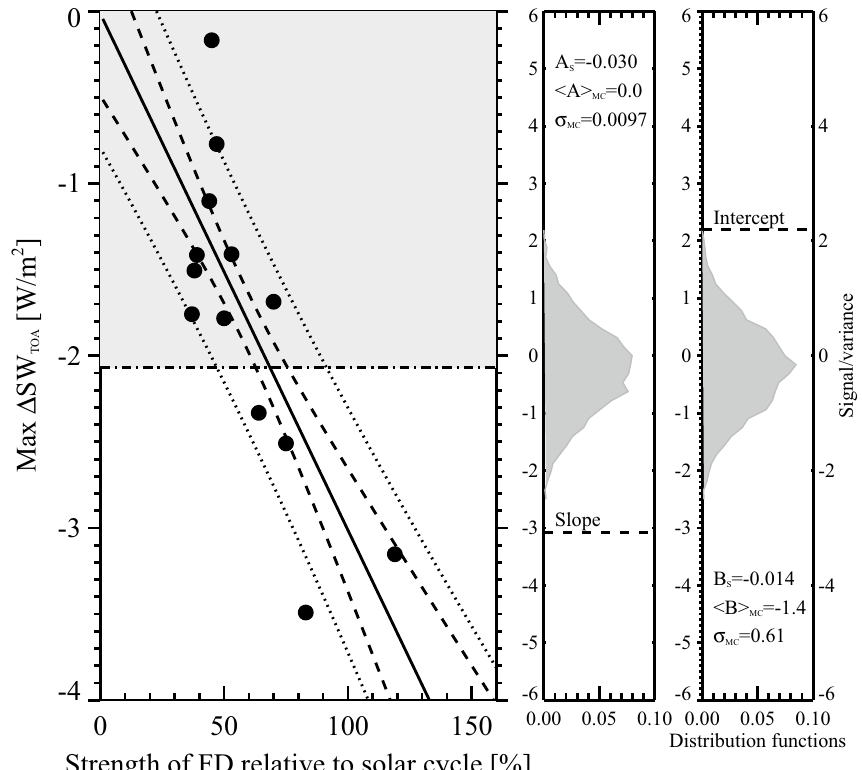
Figure 2. The response of CERES short-wave radiation as a function of FD strength. The left panel shows the most substantial deviation between day 0 and day 10 in short wave radiation globaly averaged for each Forbush decrease as a function of the FD strength (dots). The black line is a linear fit to the 13 data points and the dashed lines and dotted lines represent two and four standard deviations of the fit, respectively. The dash-dotted line is 4 the mean of the most substantial deviation between day 0 and day 10 using 10 Monte Carlo simulations with random FD dates. The black circles are the 13 FDs. The two panels to the right display the distribution functions 4 of the slope and intercept of the linear fit, based on 10 Monte Carlo simulations using CERES SW data with random dates for the FD. Note that the significance of the above linear slope is ∼ 3 σ , and that the Monte Carlo simulations using random dates for the FD events result in an average zero slope as